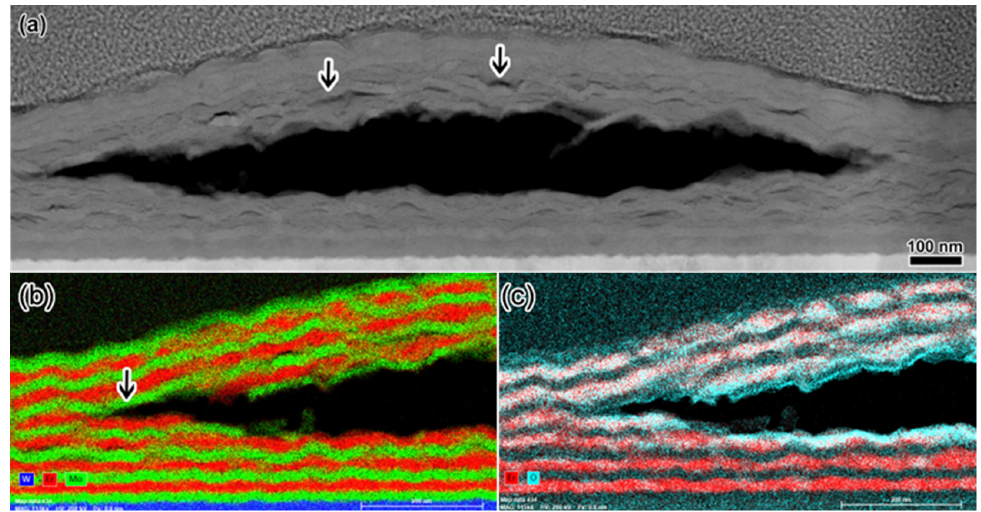
Figure 6. Blister formation in bulk implanted multilayers after the highest implantation fluence of 2.5 × 10 17 He/cm 2 . ( a ) HAADF image of a blister cross-section. Arrows point to crack formation along multilayer interfaces. The gas-filled blister gap is apparent in ( a ). Frame ( b ) shows EDXS maps of the Mo (green) and Er (red) layers. Arrow points to the fracture surface where the blister gap formed. The O EDXS map (blue) in ( c ) allows identification of the layers (primarily Er layers) where oxide is present.